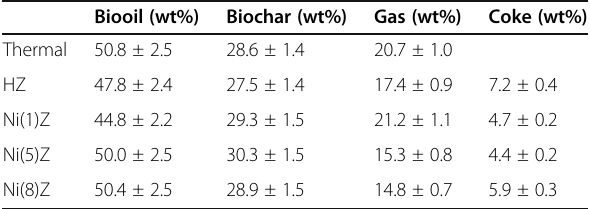
Table 2 Mass balance of PS pyrolysis reactions catalyzed